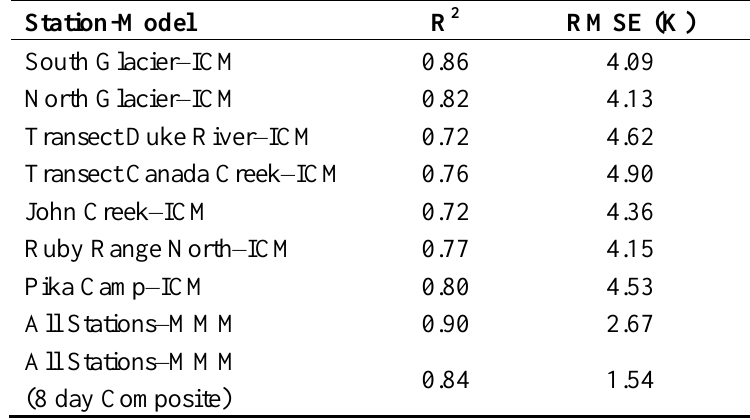
Table 2. Coefficient of determination (R 2 ), root mean square error (RMSE) and skew between daily air temperature averages and modeled mean daily surface temperature (ICM and MMM).